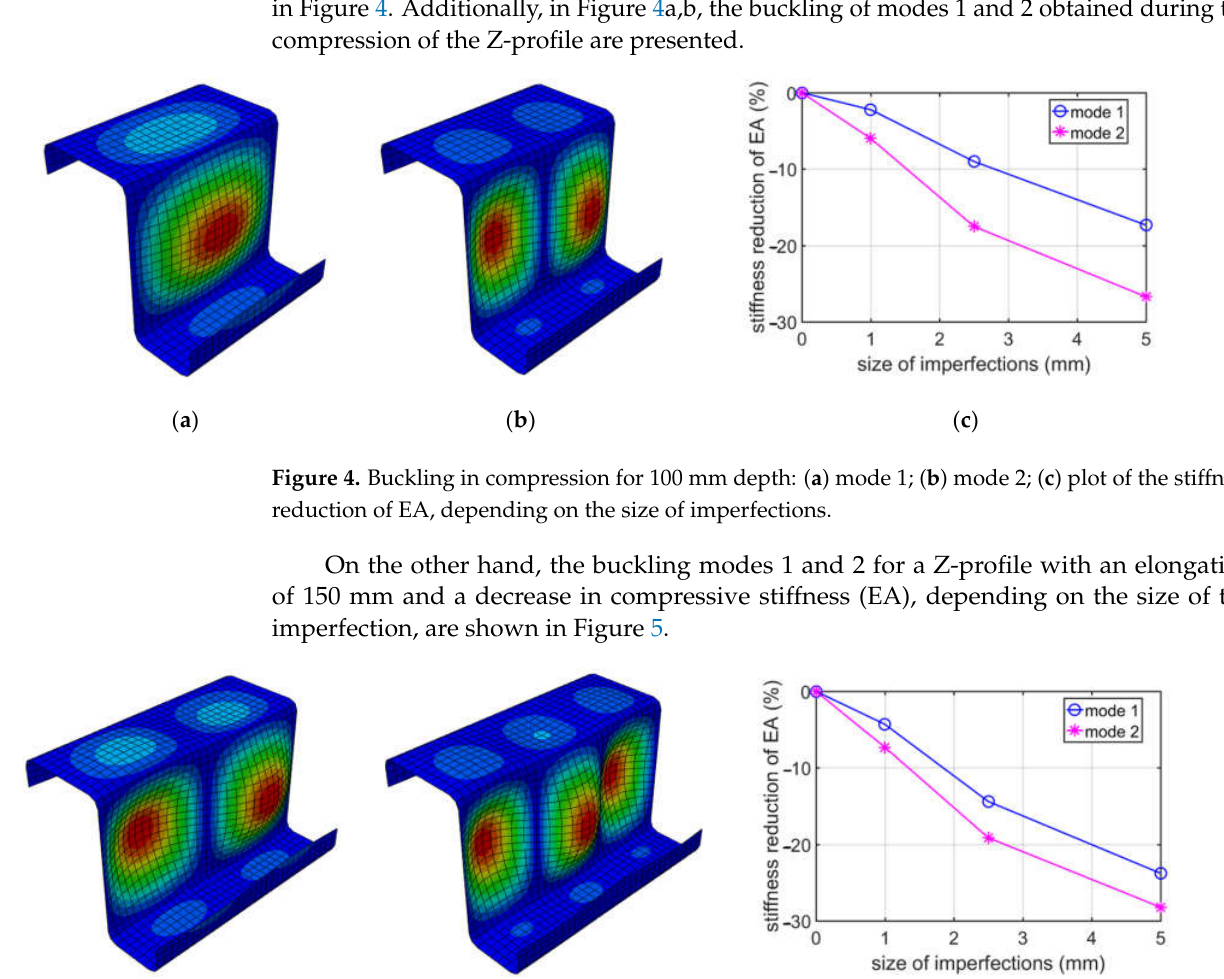
( c ) Figure 6. Buckling in compression for 200 mm depth: ( a ) mode 1; ( b ) mode 2; ( c ) plot of the stiff- ness reduction of  , depending on the size of imperfections. 3.2. Buckling due to Bending about the Horizontal Axis Buckling due to bending about the horizontal axis of the cross-section was consid- ered for two cases: (i) the tension of the upper part of the cross-section and (ii) the ten- sion of the lower part of the cross-section, because the cross-section considered has no axis of symmetry. For the Z-type cross-section with 100 mm elongation, the influence of the imperfection size on individual stiffness was investigated. The stiffness reduction due to bending for the (i) case is presented in Table 3 in percentages. Figure 7 shows the first buckling mode due to bending for case (i) (tension of the upper part of the cross-section) and the reduction of bending stiffness EI  about the horizontal axis depending on the size of imperfections for a Z-type profile with 100 mm elongation. Table 4 shows the stiffness drops depending on the size of imperfections for (ii), the case of bending about the horizontal axis, when the lower part of the cross-section is in tension. The results refer to the Z-type profile with 100 mm elongation.